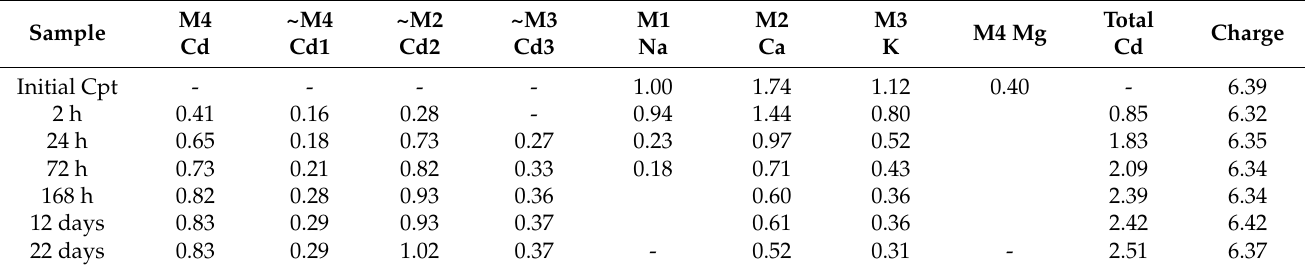
Table 6. Number of atoms per unit cell in the cationic positions of initial and Cd-exchanged clinoptilolite (Cpt) at 90 ◦ C.